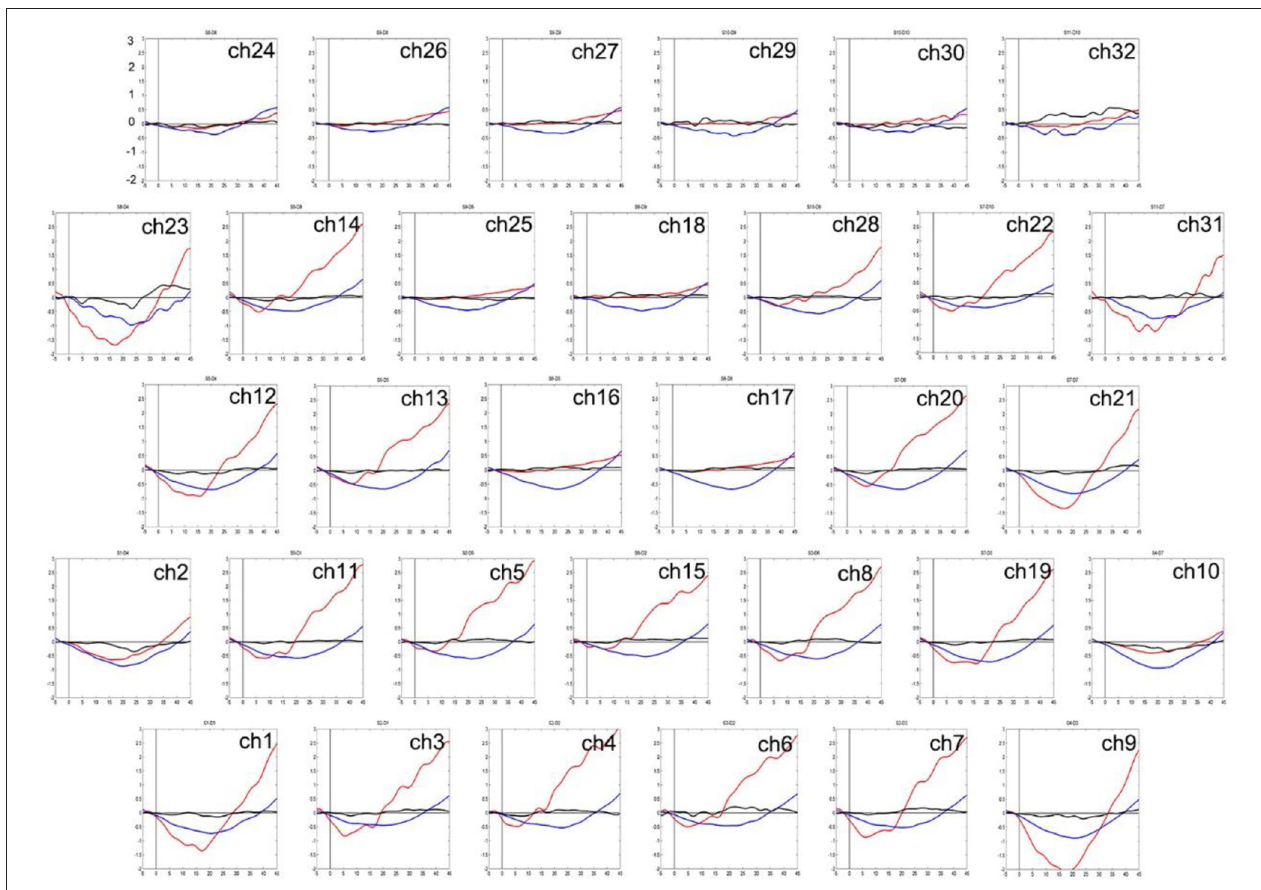
FIGURE 5 | The time course of mean hemodynamic changes ( Z -values) of 32 channels during the TOL task. The ordinate is the mean hemodynamic changes ( Z -value, *10 − 1 mmol.mm), and the abscissa is the time course of the task. HCs (red); MDD patients (blue); SZ patients